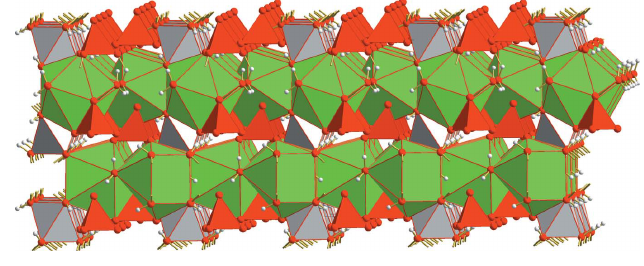
Figure 6 Polyhedral model showing the packing of two layers.